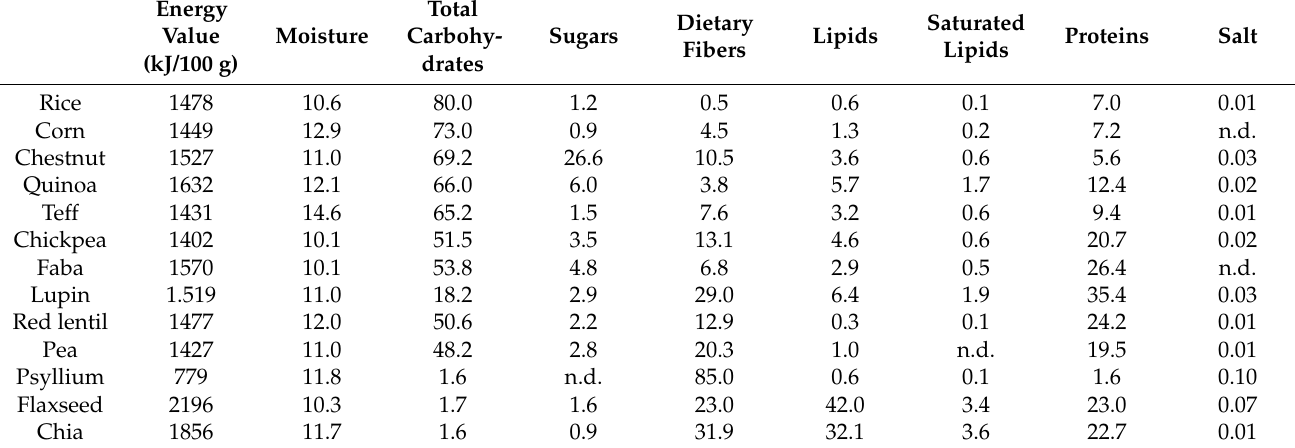
Table 1. Proximate composition (percentage) of the flours used in this study as reported on the commercial labels.